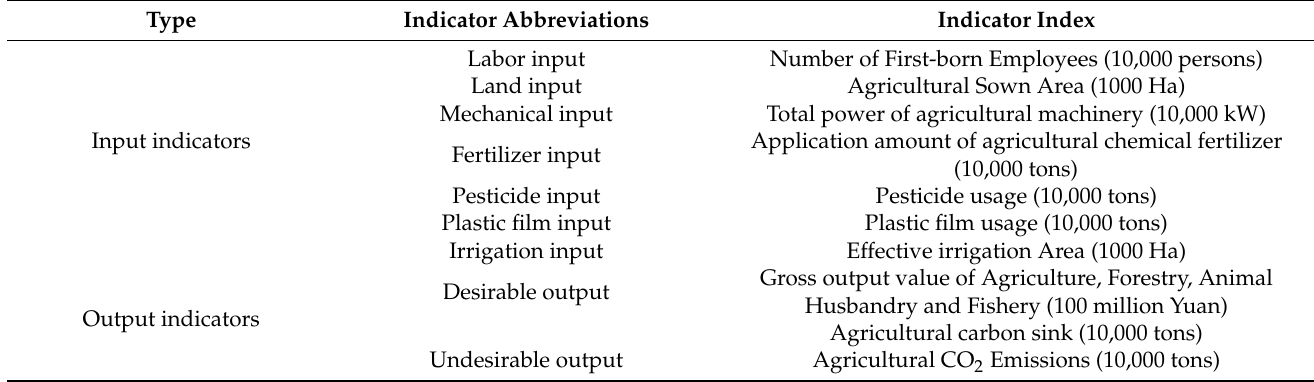
Table 1. Agricultural carbon reduction efficiency measurement index